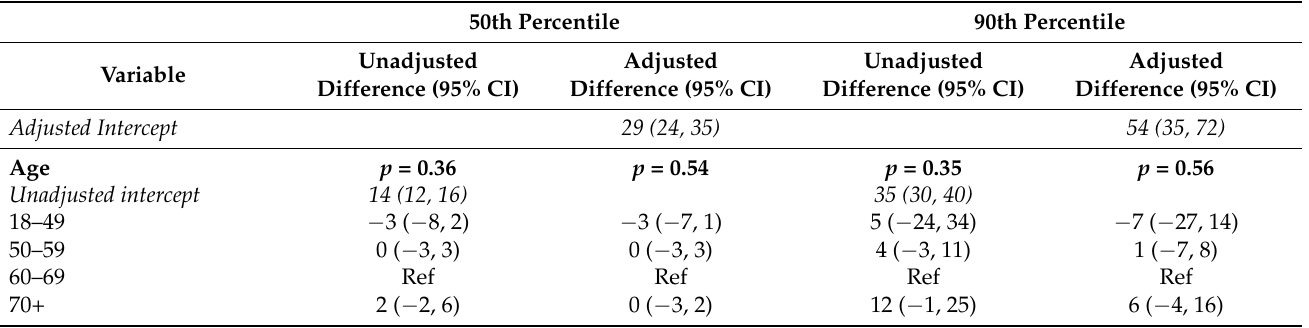
Table 4. Unadjusted and adjusted differences in TTC (days) at the 50th and 90th percentiles according to the factor categories in Ontario patients undergoing trimodal treatment for esophageal cancer between 2013 and